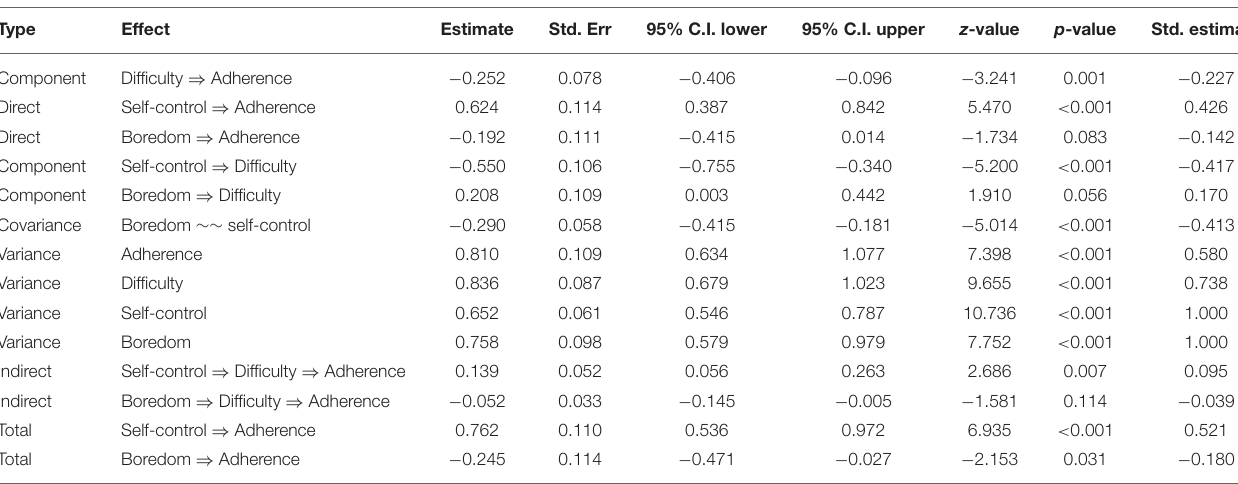
TABLE 3 | Homeschooling